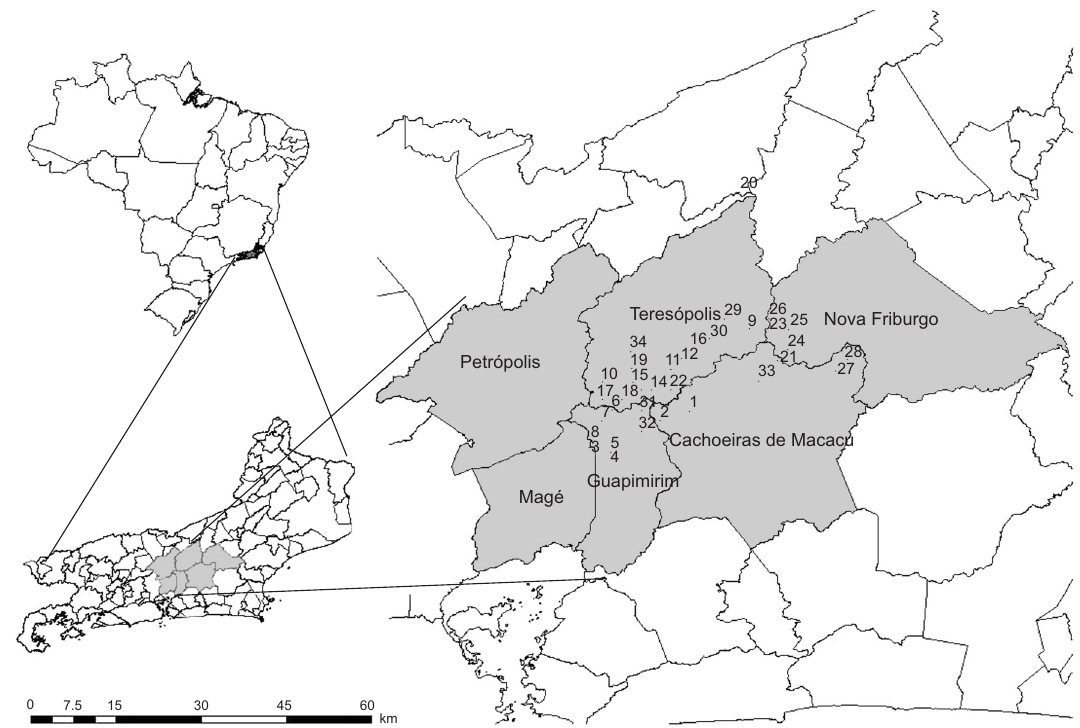
Figure 1. Map of the Serra dos Órgãos region showing study localities and municipalities. Numbers represent the localities (see Material and